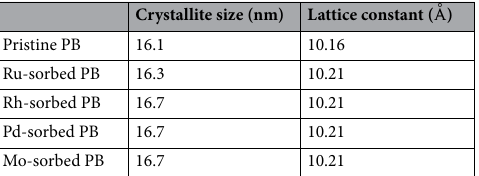
Table 2. The crystallite size and lattice constant of the pristine and PGMs/Mo-sorbed PBNPs.